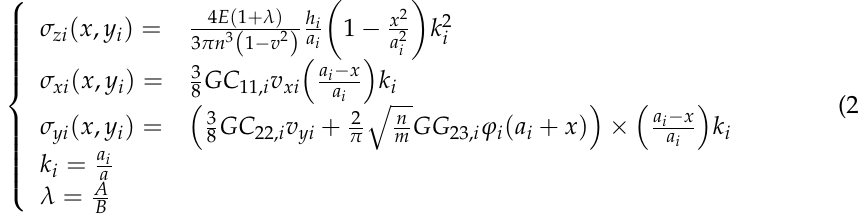
( b ) Figure 3. Nonlinear suspension stiffness: ( a ) the anti-yaw damper and ( b ) the lateral stop. 2.2. Turnout Model The turnout model is an elastic track model based on the standard CHN60–1100–1:18 turnout design for high-speed railways (the curve radius is 1100 m, and the turnout angle is 1:18). The total length of the turnout is 69 m, and a straight line of 100 m is established in front of the turnout. The nominal rail profile changes continuously along the turnout. Based on the critical rail sections of the turnout, as shown in Figure 4a,b, longitudinal interpolation is per- formed along the rail, which interpolates variable rail cross-sections between the various profiles in the longitudinal direction employing Bézier curves [29]. The numbers of cross- sections in the switch and crossing panels are 72 and 48, respectively, and the variable cross-section lengths of the switch and crossing panels are 21.3 and 14.1 m, respectively